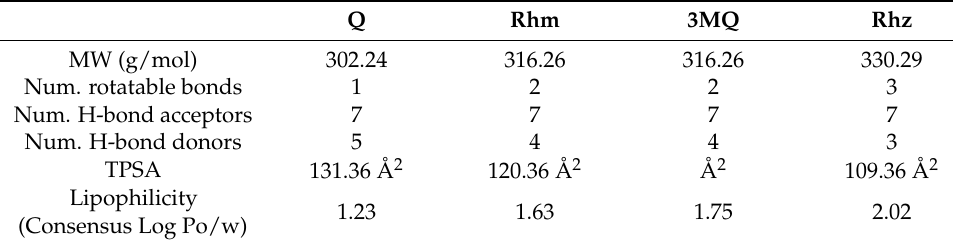
Table 1. Physical–chemical characteristics from Q, Rhm, 3MQ and Rhz. Q Rhm 3MQ Rhz MW (g/mol) 302.24 316.26 316.26 330.29 Num. rotatable bonds 1 2 2 3 Num. H-bond acceptors 7 7 7 7 Num. H-bond donors 5